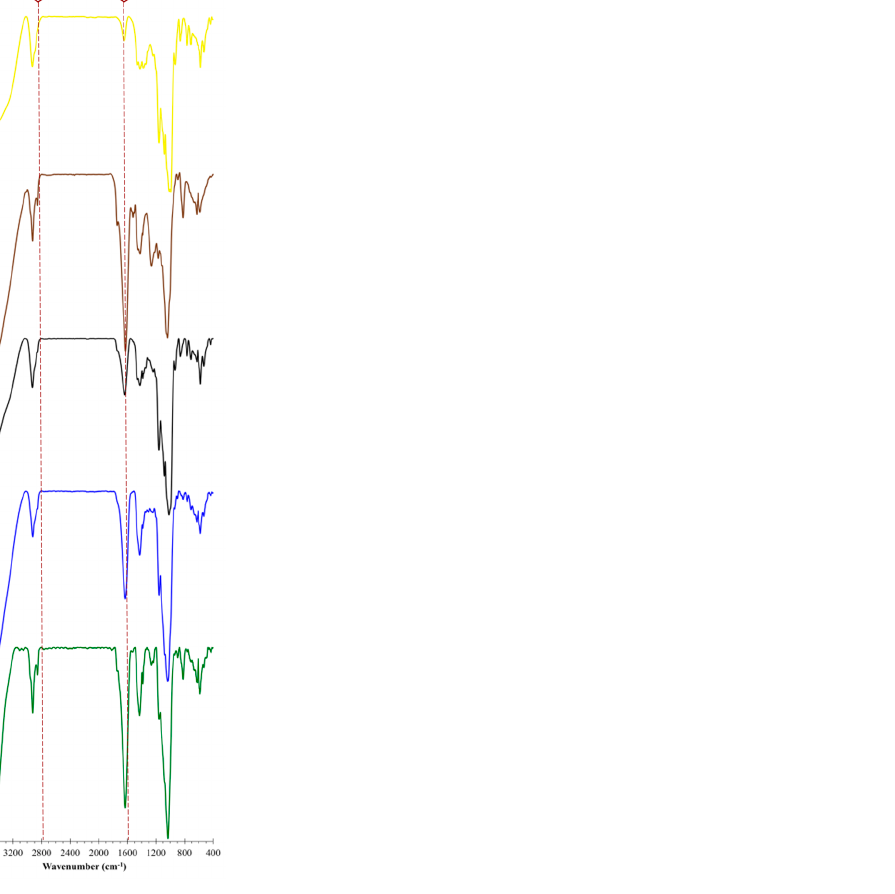
Figure 5. FT-IR spectra of control (CS, and AF, ) and AF–CS (1:1 ratio) samples (NT, , GL, , and CGL, methods).